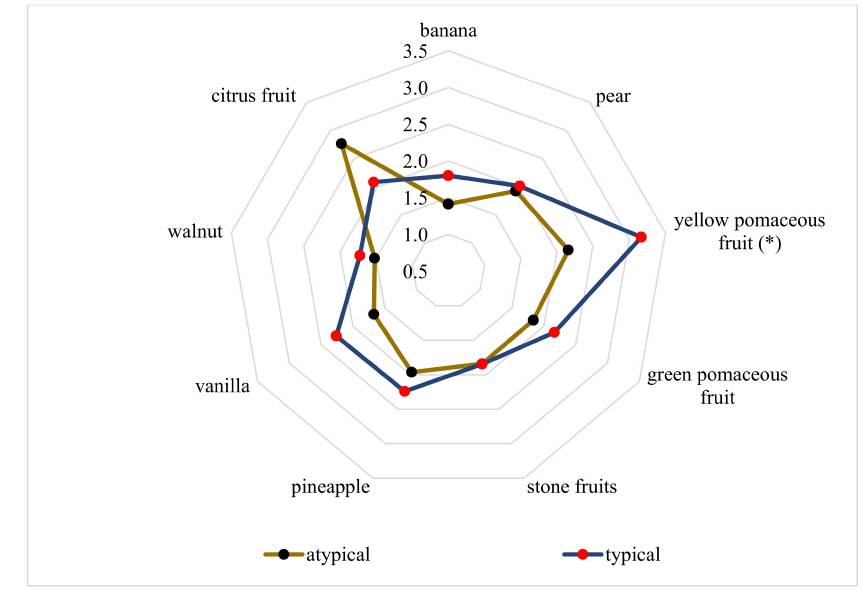
Figure 2. Tasting results of the average value of eight typical and atypical Pinot blanc samples: * indicates a significant di ff erence based on a Mann-Whitney U test ( α ≤